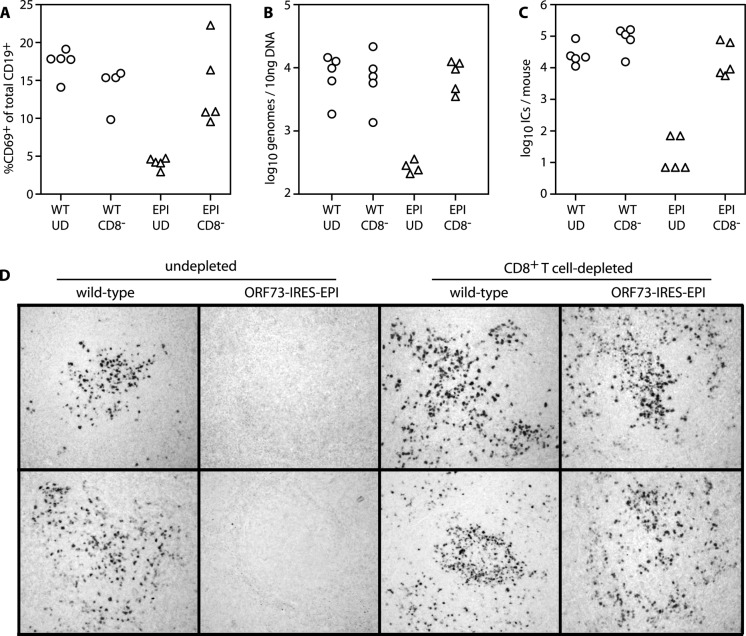
Rescue of the EPI Virus by CD8+ T Cell DepletionMice were left undepleted (UD) or depleted of CD8+ T cells (CD8−) by an initial intravenous injection of mAb YTS169 2 d before infection, followed by intraperitoneal injections of the same antibody every 2–3 d up to the time of sampling. Infection was by intranasal inoculation of either WT or EPI viruses.(A) Depletion was 95%–99% complete as assessed by flow cytometry of spleen cells. CD69 expression on splenic B cells was measured 13 d post-infection.(B) Genome loads were measured 13 d post-infection by real-time PCR. Each point shows an individual mouse.(C) The infectious centre titres of individual mice at 13 d post-infection are shown for one of two equivalent experiments. The titres of pre-formed, infectious virus in freeze-thawed spleens were less than 5% of the infectious centre titres, so even after CD8+ T cell depletion, the infectious centre assay essentially measured latent virus. By 13 d post-infection, the lungs of both immunocompetent and CD8+ T cell–depleted mice were clear of infectious virus.(D) In situ hybridization for viral tRNA expression in splenic germinal centres is shown 13 d after infection of CD8+ T cell–depleted or undepleted mice, infected with either EPI or WT virus. Spleens of two representative mice are shown in each case.